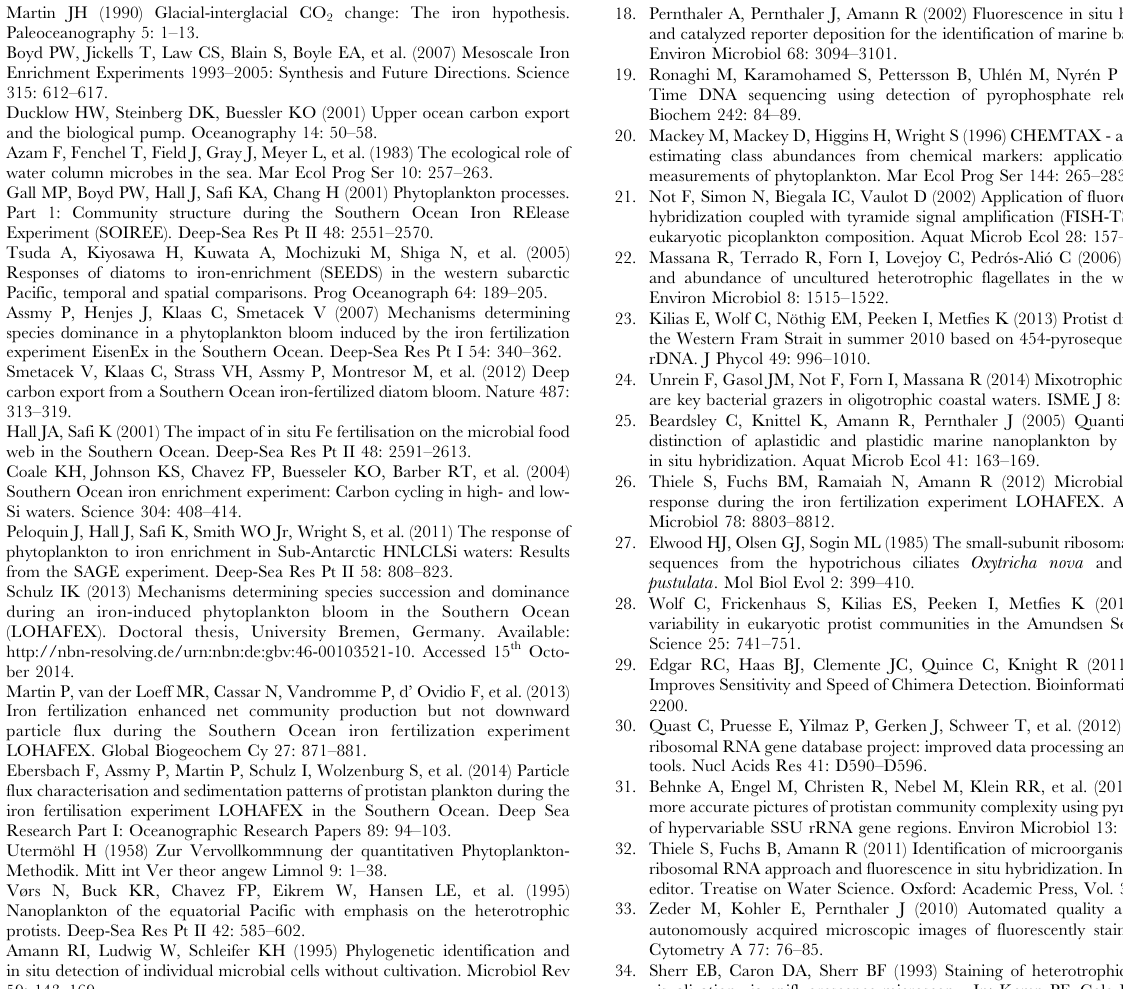
Neighbour Joining algorithm. The aligned consensus tag sequenc- es were added with parsimony criteria to the trees and percentage of tags falling into the respective clade are given behind the clades. Values in the wedges represent the number of reference sequences.